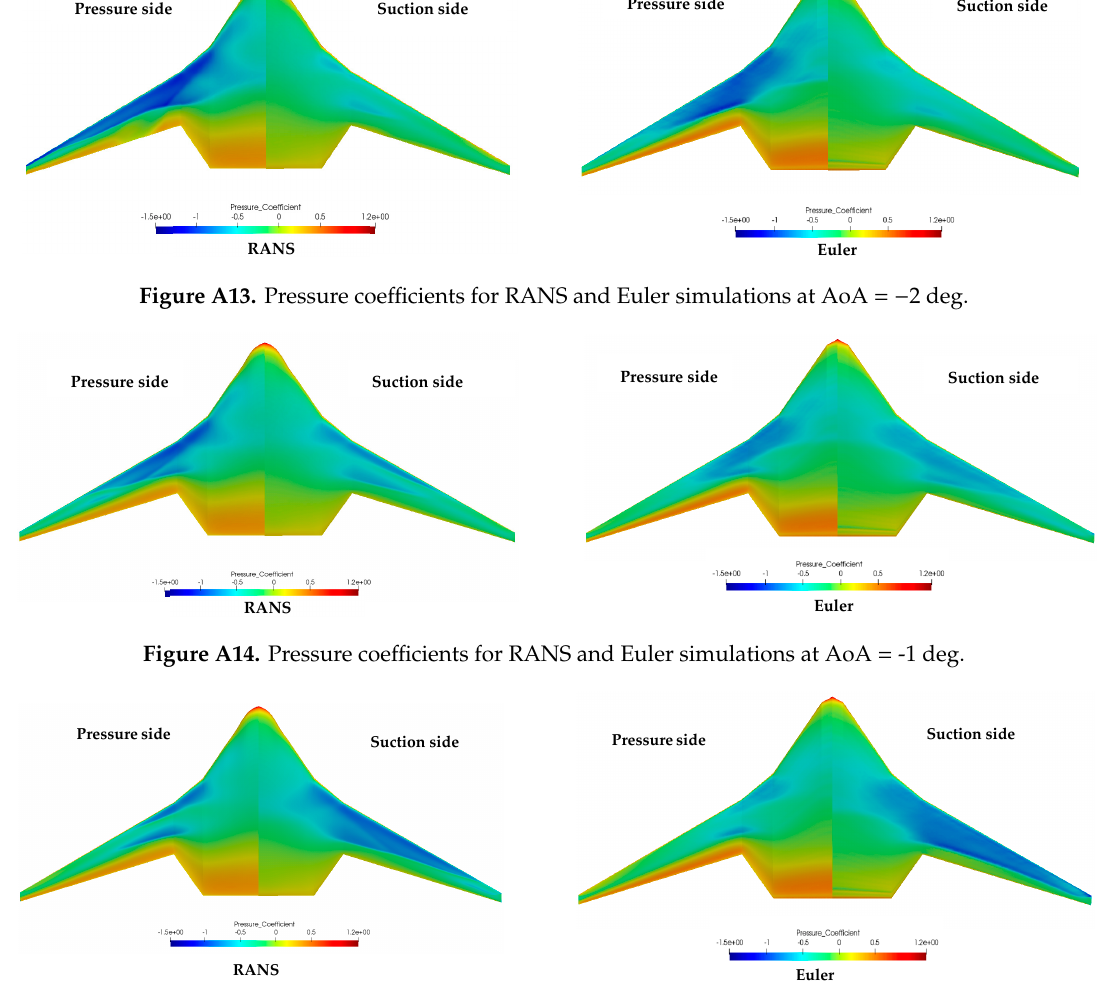
Figure A15. Pressure coefficients for RANS and Euler simulations at AoA = 0 deg.